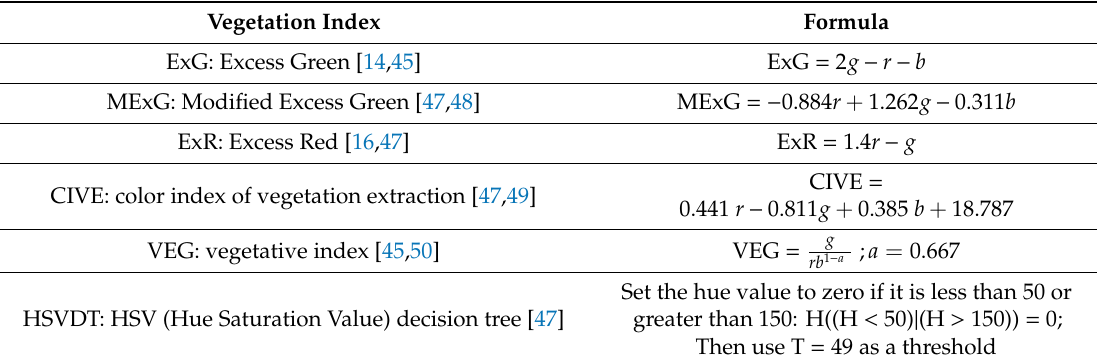
Table 2. Names and formulas of the six vegetation indices used to build the MetaIndex. Vegetation